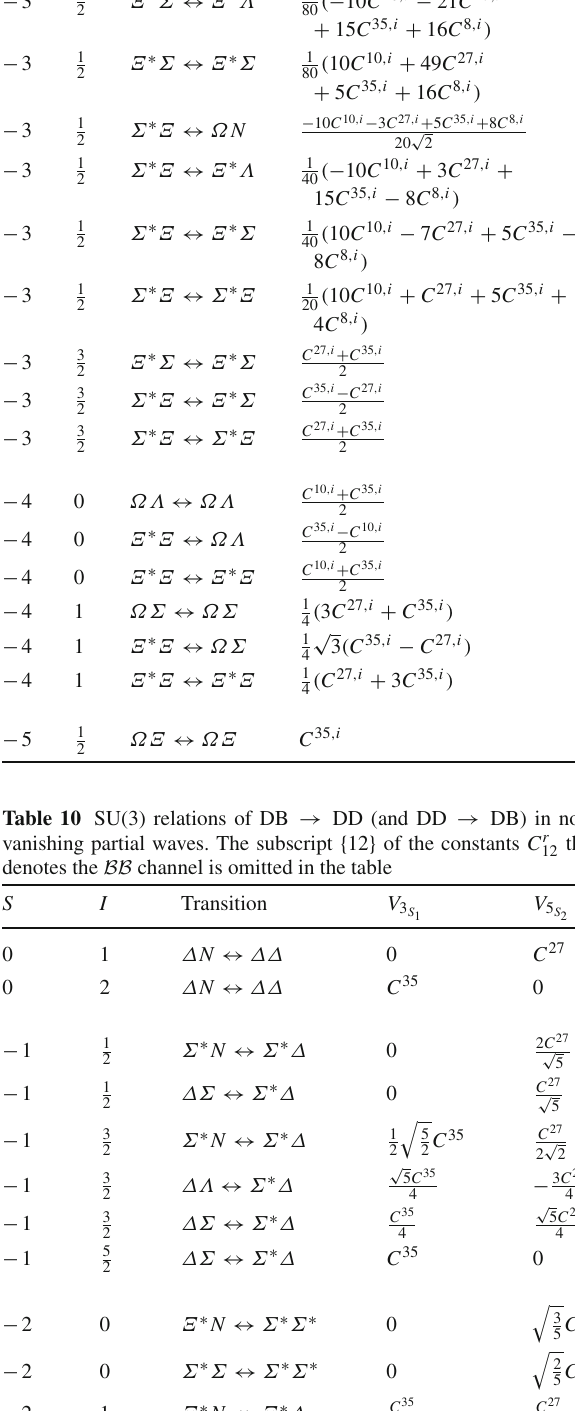
that denotes the BB channel is 11